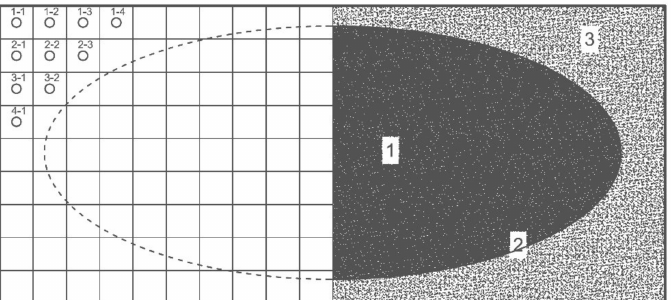
Figure 4. On the left side: Diagram of a discrete grid of a heat accumulator with a phase change material; On the right side there is a diagram of the changes in the physical state of the PCM, in the cross section of the heat accumulator; 1-solid phase change material; 2-concentration border states; 3-liquid phase change